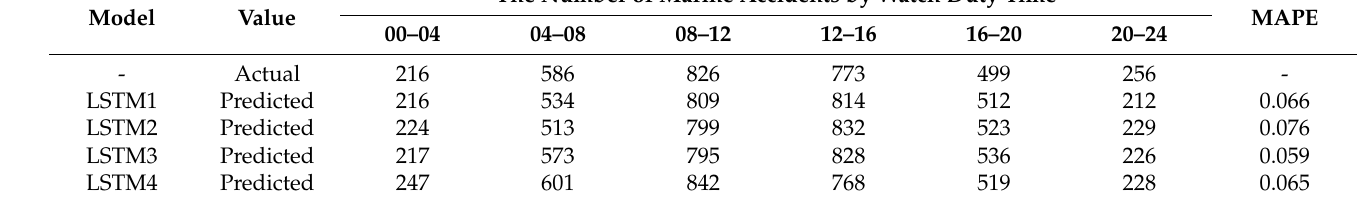
Table 7. Comparison of prediction results of four different LSTM models with the ARIMA model. LSTM3 has the smallest MAPE (0.059). Except for LSTM2, all other LSTM models outperformed the ARIMA